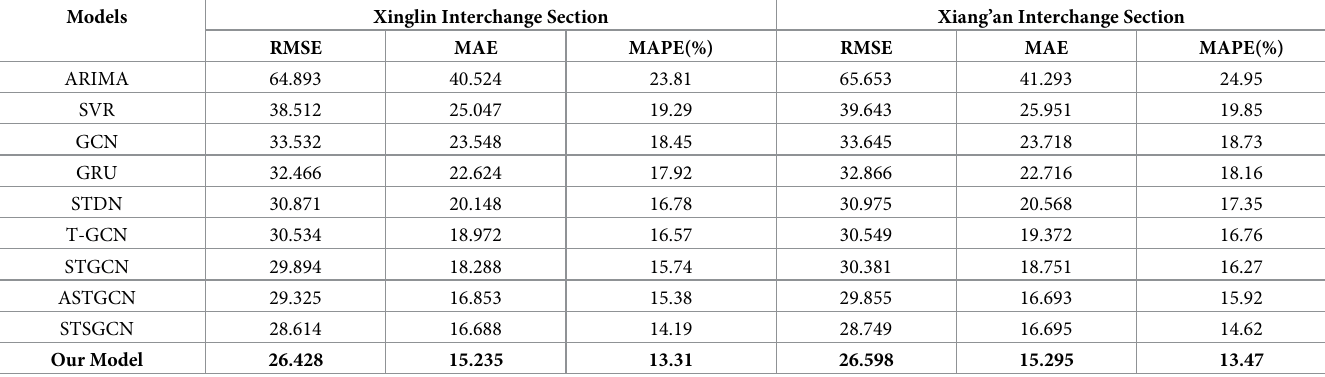
Table 4. Comparison of prediction results between Xinglin Interchange Section and Xiang’an Interchange Section.